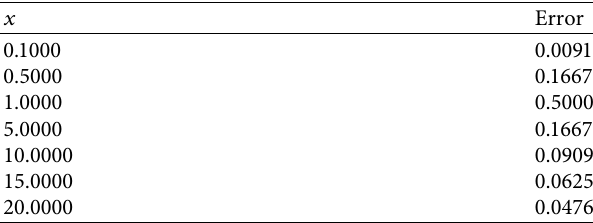
Figure 6: Statistical error versus x with y � 1. Table 6: Data of statistical error versus x with y � 1.